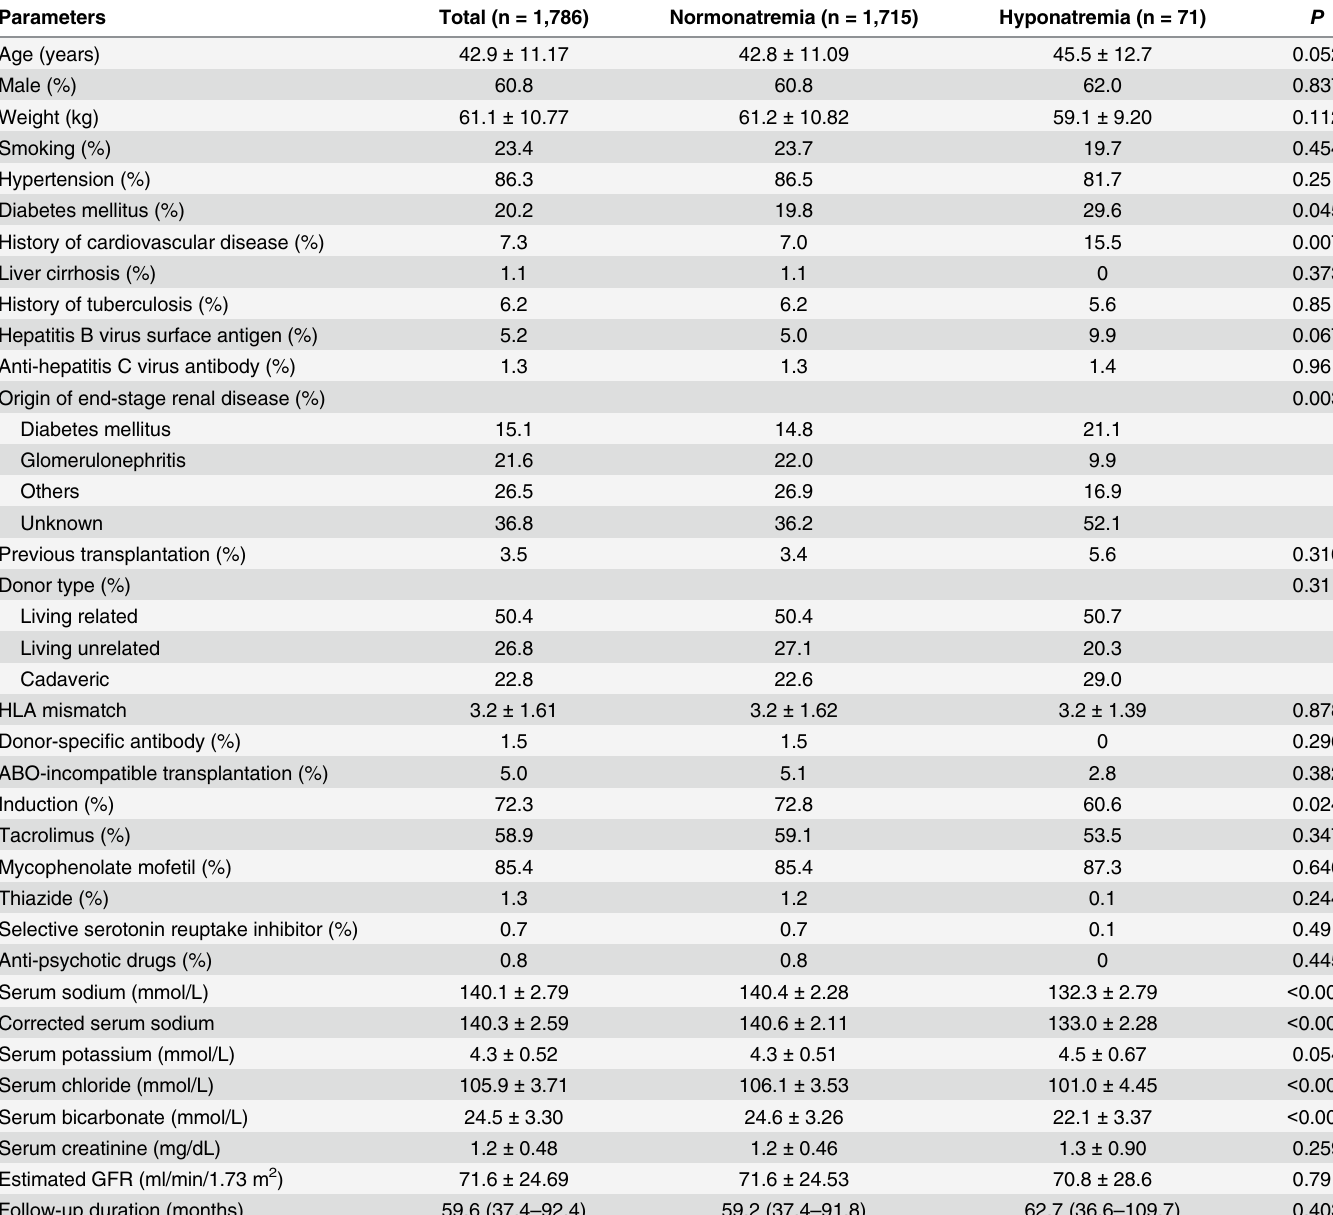
Table 1. Baseline characteristics of the study